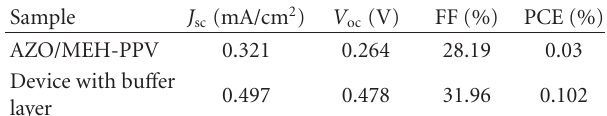
Table 2: Average PV performances of AZO/CdS/MEH-PPV and AZO/MEH-PPV devices.